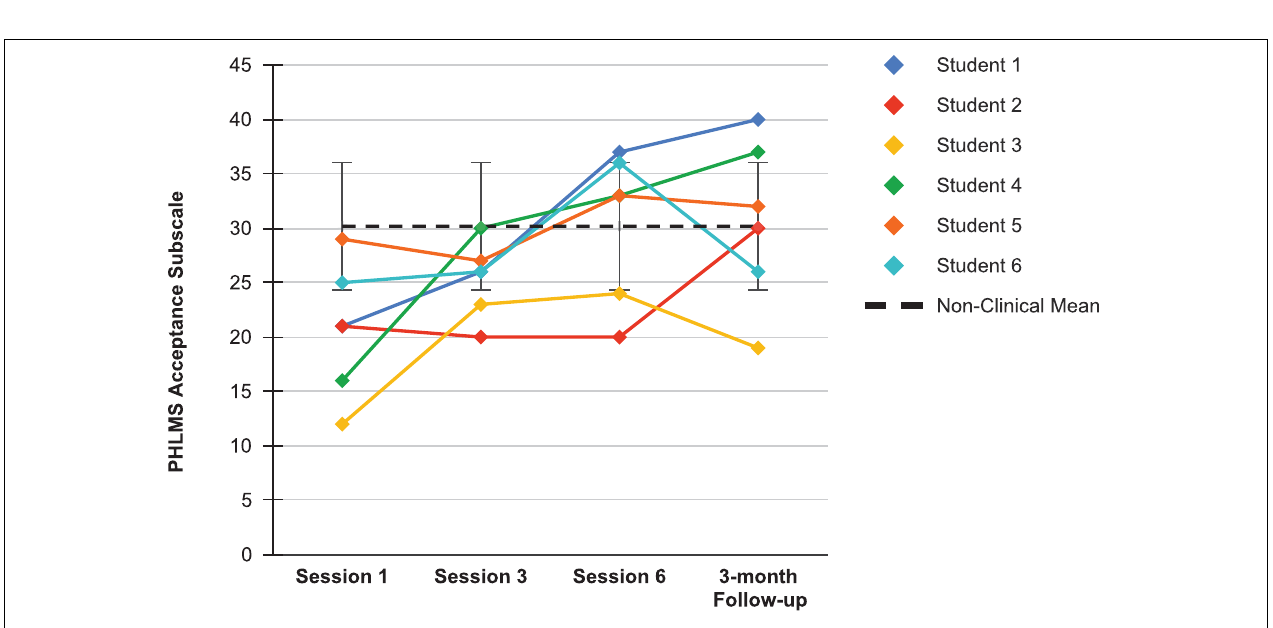
FIGURE 5 | AAQ-II scores for seven vocal students (Juncos et al., 2017) showing scores from the baseline period to post-treatment, 1- and 3-month follow-up points, also with the non-clinical mean (17.34) and bars spanning one standard deviation up/down ( SD = 4.37; Bond et al., 2011).